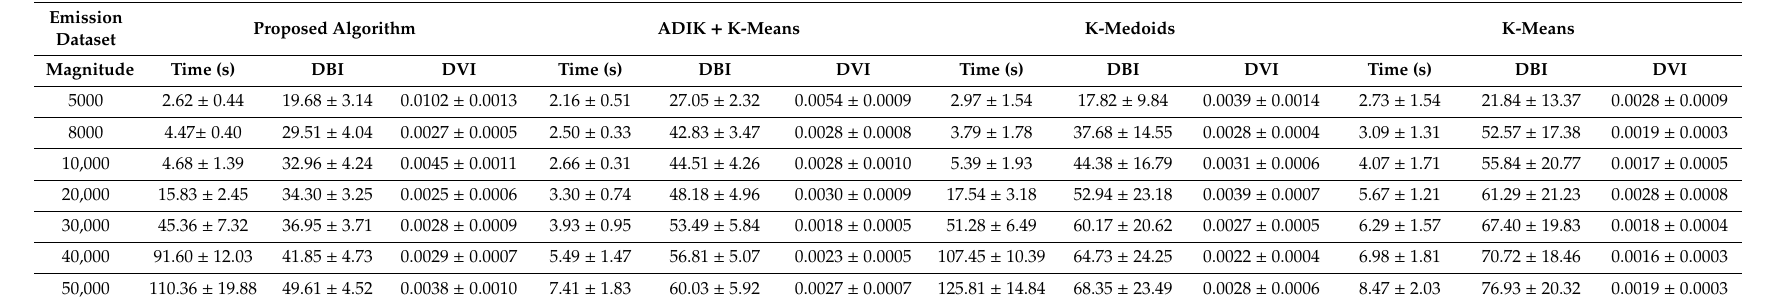
Table 2. The performance test of di ff erent clustering